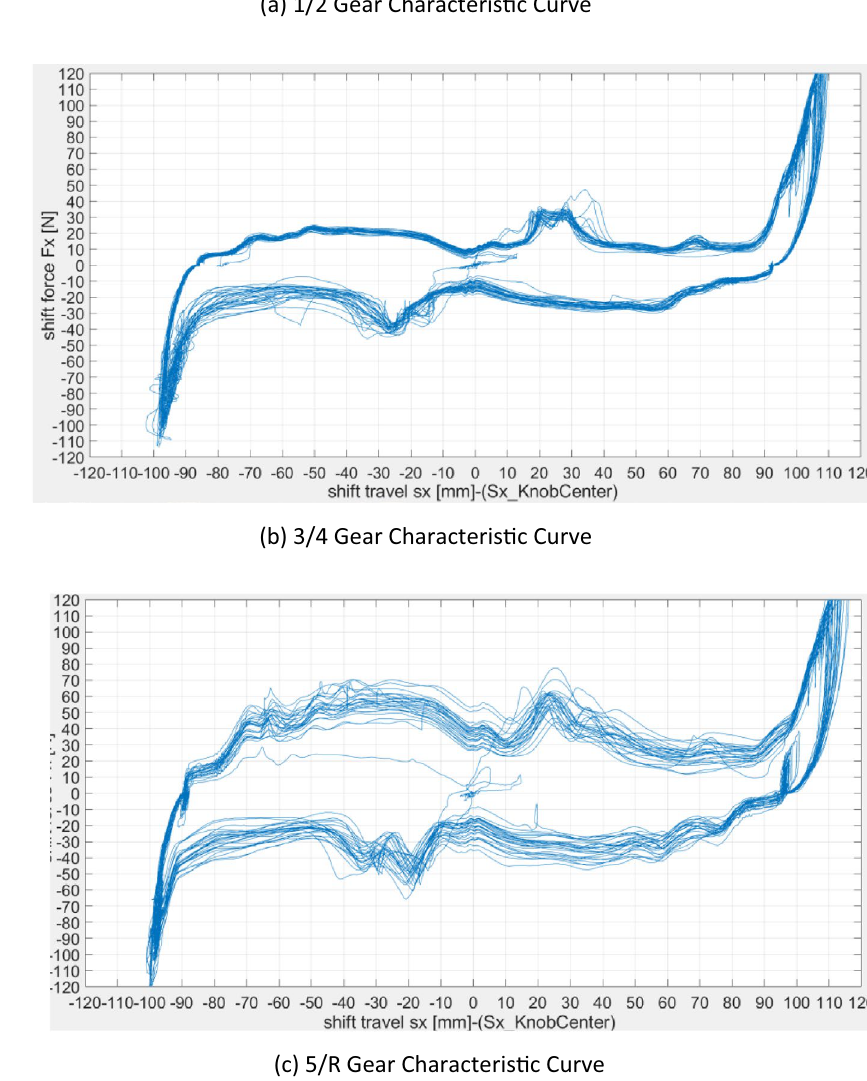
Figure 4. The characteristic curve of different